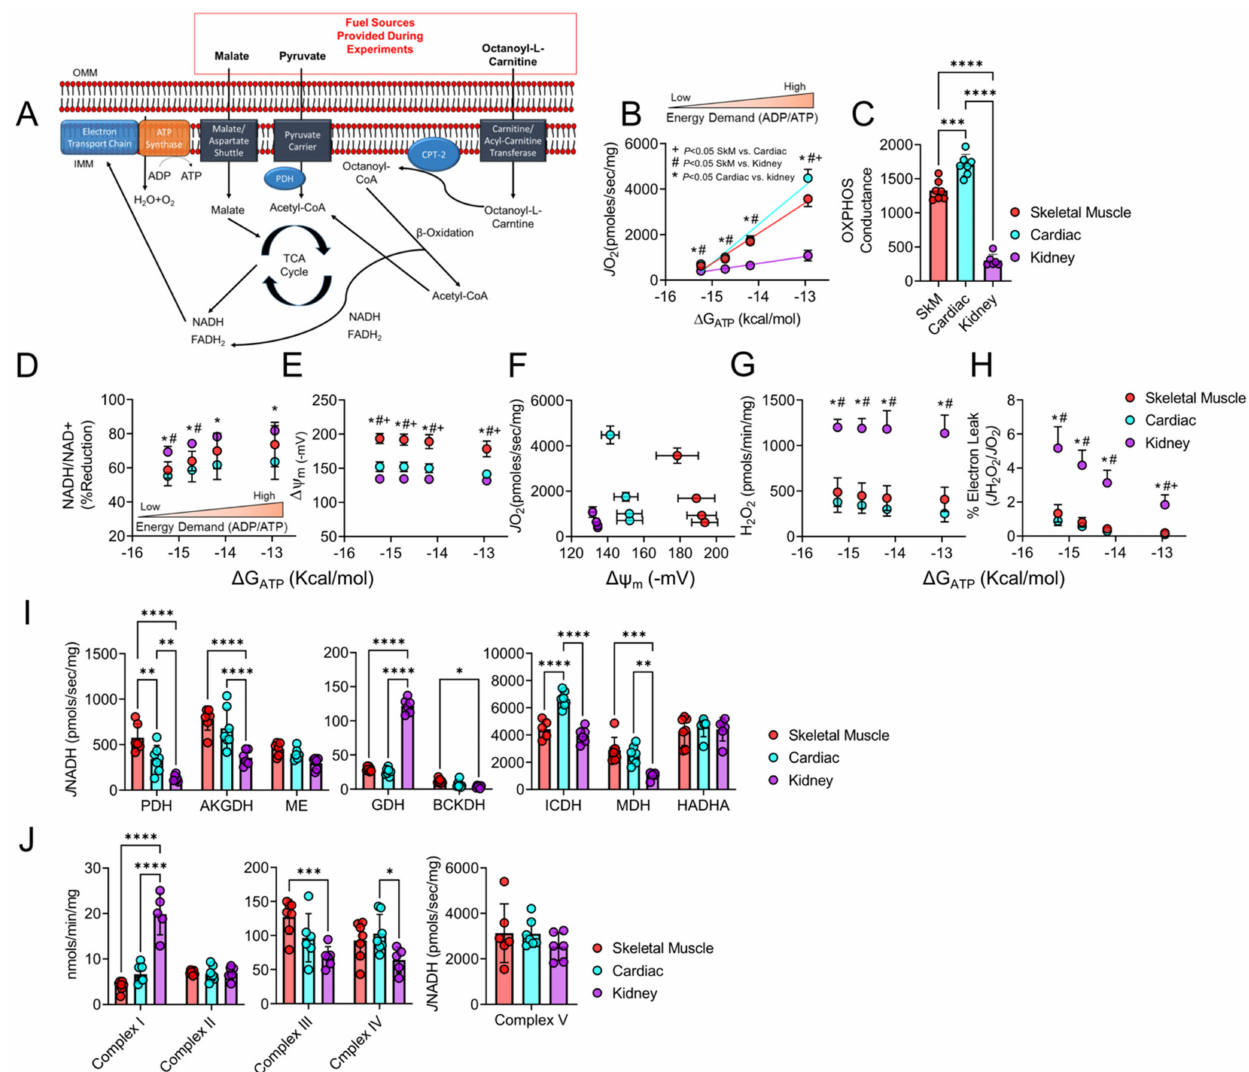
Figure 1. Skeletal muscle, cardiac muscle, and renal tissue mitochondria display distinct bioenergetic profiles in control mice. ( A ) Fuel sources and overall experimental design for bioenergetic assessments. ( B ) Next, a physiological assessment of mito- chondrial OXPHOS was employed utilizing a creatine kinase clamp system to mimic a mitochondrial stress test at relevant levels of extramitochondrial energy demand to compare tissue energetics. ( C ) Quantification of each tissue types OXPHOS conductance (slope of J O 2 vs. ∆ G ATP ) ( n = 6–7/group). ( D ) Relationship between NADH/NAD+ and NADPH/NADP+ redox state expressed as percentage reduction vs. Gibbs energy of ATP hydrolysis ( ∆ G ATP ). ( E ) Mitochondrial membrane potential ( ∆Ψ ) in millivolts. ( F ) H 2 O 2 production vs. ∆ G ATP . ( G ) Mitochondrial respiratory efficiency evaluated via plotting J O2 vs. ∆Ψ . ( H ) Mitochondrial electron leak plotted against ∆ G ATP ( n = 6–7/group). ( I ) Matrix dehydrogenase activity was measured for the following enzymes: pyruvate dehydrogenase (PDH), alpha ketoglutarate dehydrogenase